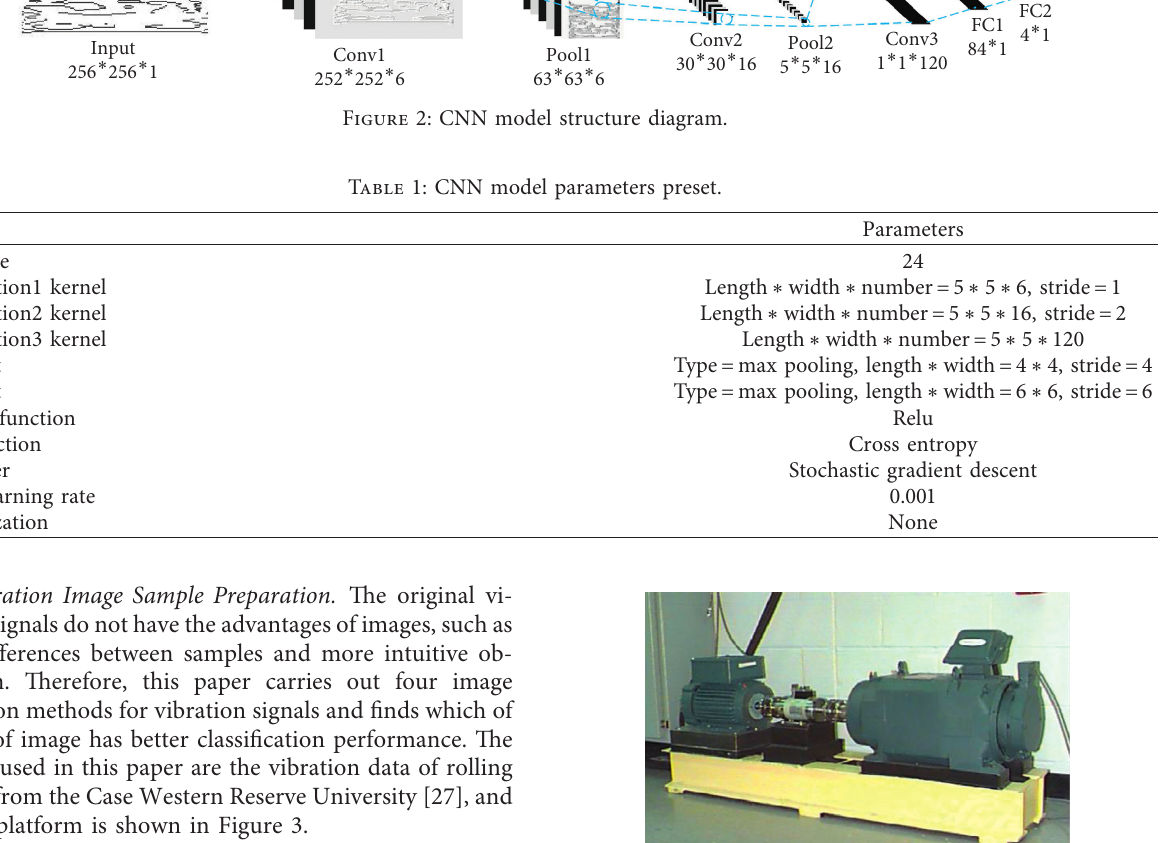
Figure 3: Bearing test platform of Case Western